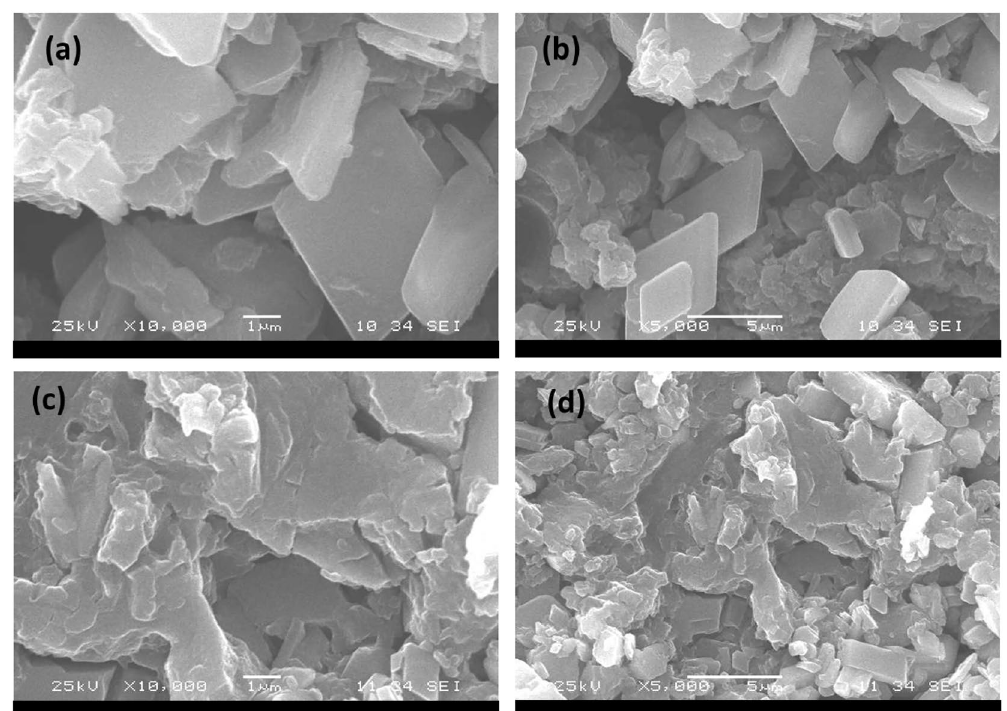
Figure 4. SEM micrographs for GO- ziziphus Seeds, ( a , b ) before, ( c , d ) after